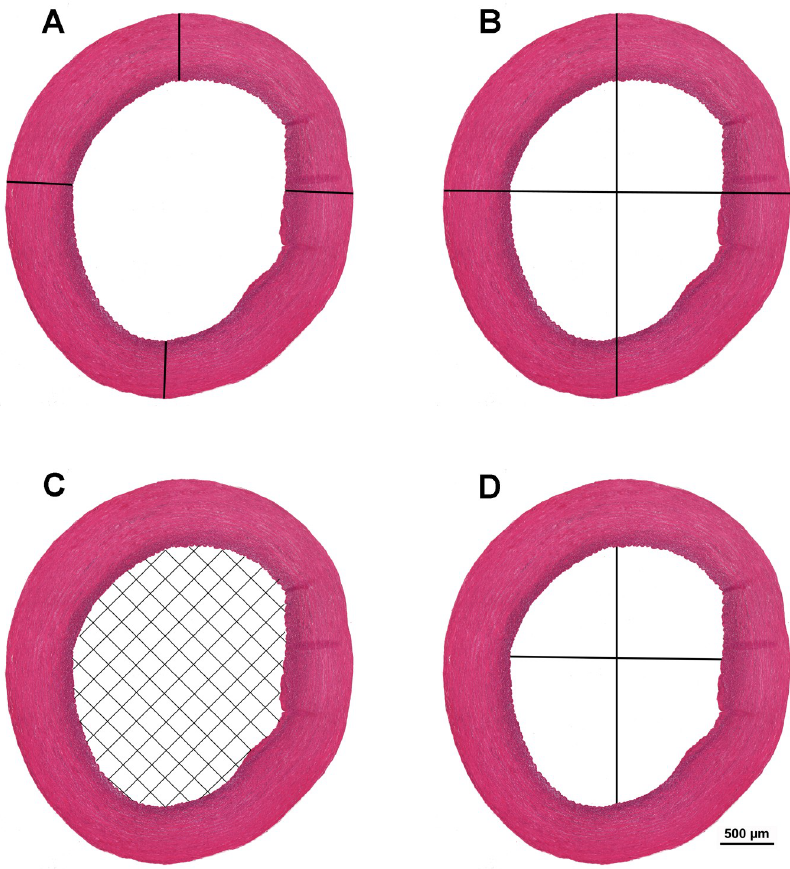
Fig 3. Cross-section of aortic wall of a 7-day-old Lohmann Dual chicken. ( A) aortic wall thickness, ( B) aortic diameter, (C) cross sectional area of aortic lumen, (D) diameter of aortic lumen. H&E.